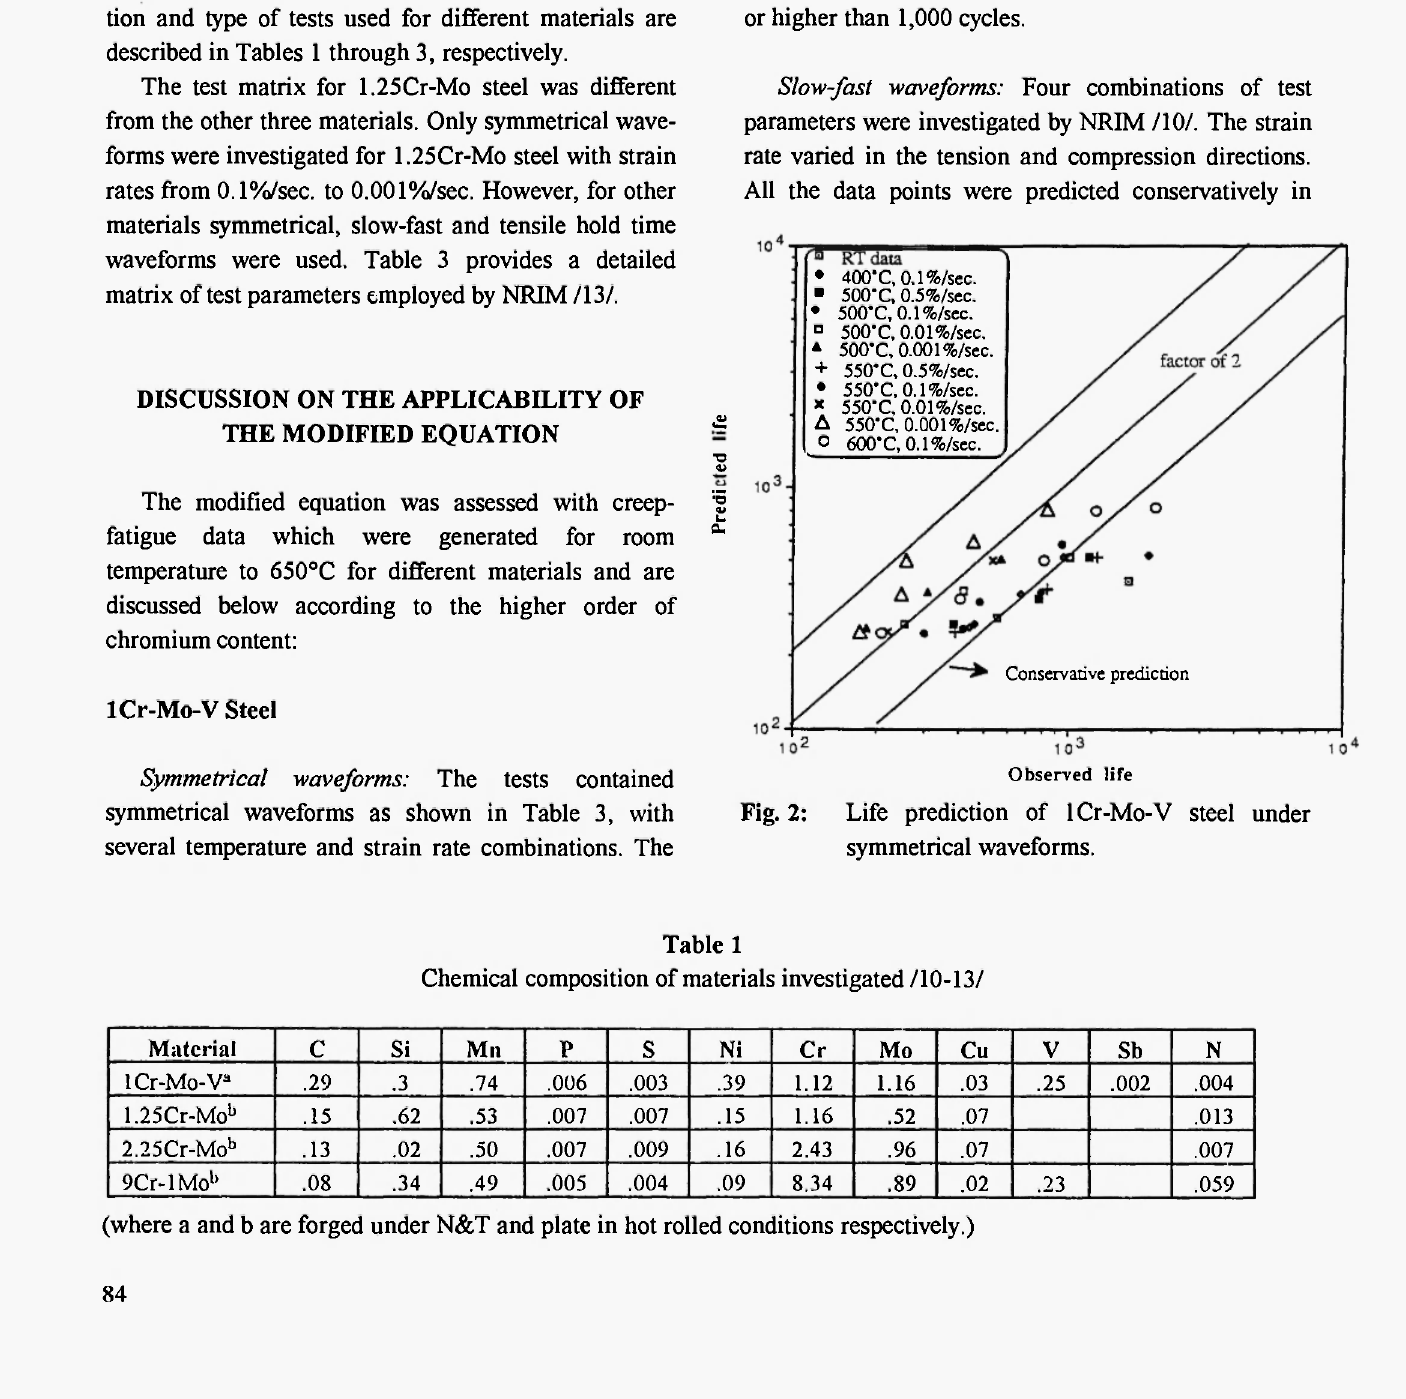
predicted by a factor of ± x2. The life prediction was higher strain rates, e.g. 0.5%/sec and 0.1%/sec, were under-predicted when the experimental life was near to or higher than 1,000 cycles. Slow-fast waveforms: Four combinations of test rate varied in the tension and compression directions.